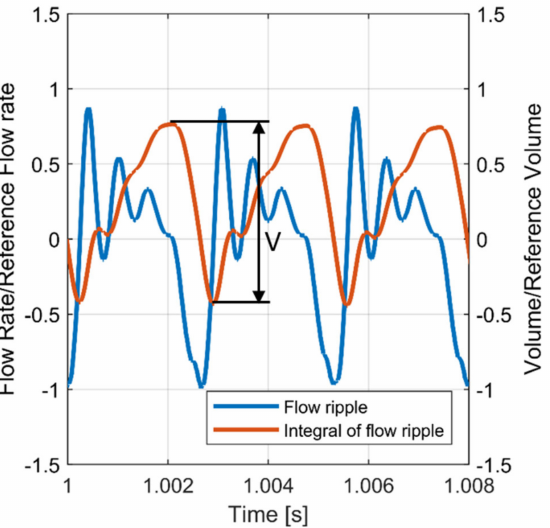
Figure 3. Simulated pump delivery flow ripple and its integral, 250 bar, 2500